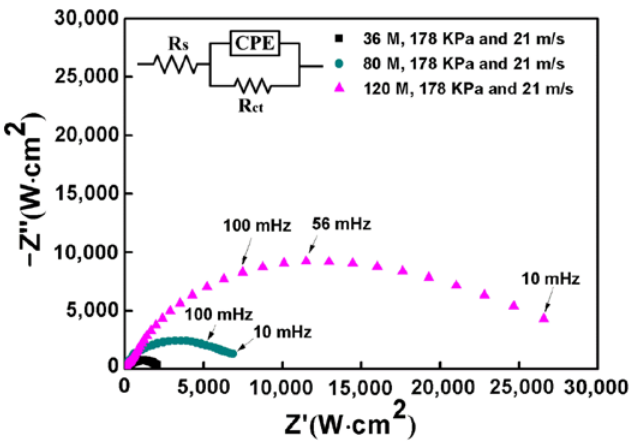
Figure 3. Nyquist plots of the ground surface with different abrasive particle sizes. Constant phase elements (CPE).